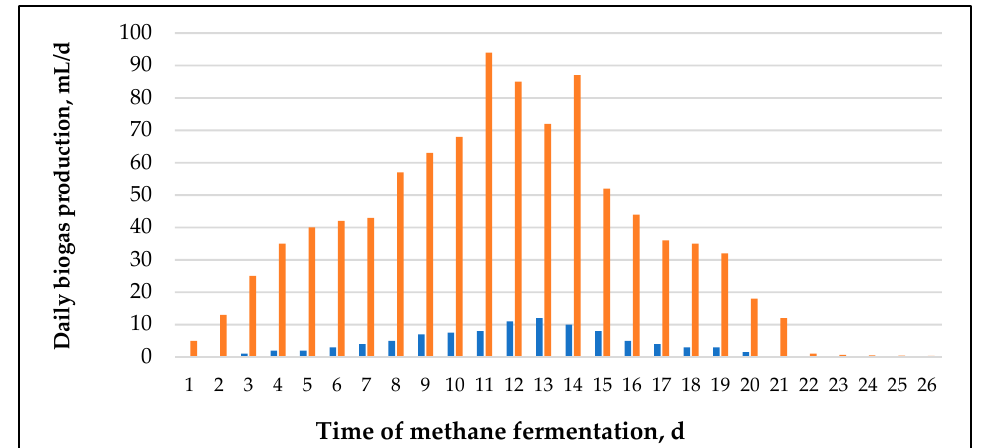
Figure 11. Biogas generation from non-pretreated excess sludge (sludge A) and chemically pretreated excess sludge with the reagent dose of 3.0 mL STERIDIAL W-10/L (sludge B).